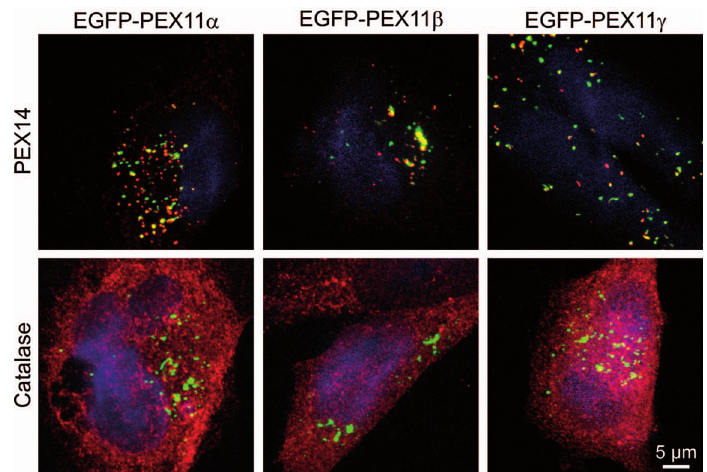
Figure 5 Pex11 membrane elongation factors do not require peroxisomal matrix content to function. Analysis of mutant fibroblast cells with mutated PEX5 containing empty peroxisomal membranes for the effect of ectopic expression of GFP-tagged human Pex11 proteins. Pex11 proteins elongated the peroxisomal membrane in the absence of matrix content as demonstrated by immunofluorescent stainings for the peroxisomal membrane protein PEX14 (red channel, upper panel) and the matrix protein catalase (red channel, lower panel). Images represent maximum intensity projection of confocal images acquired on a LSM510META w objective 100 = 1.45; settings: EGFP (488 nm, MBS 488, BP 500–525), AlexaFluor594 (561 nm, MBS 561, LP 585) x